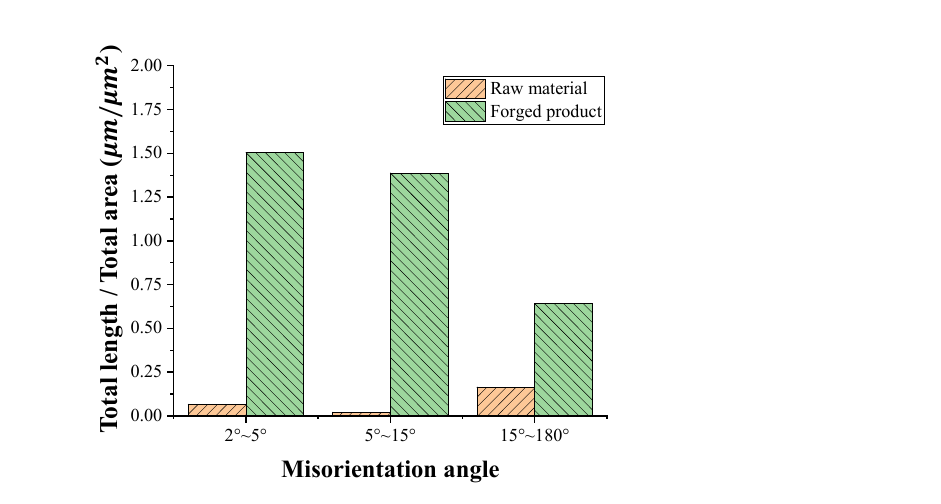
Figure 13. Comparison of areal fraction of misorientation angles for raw material and forged product.